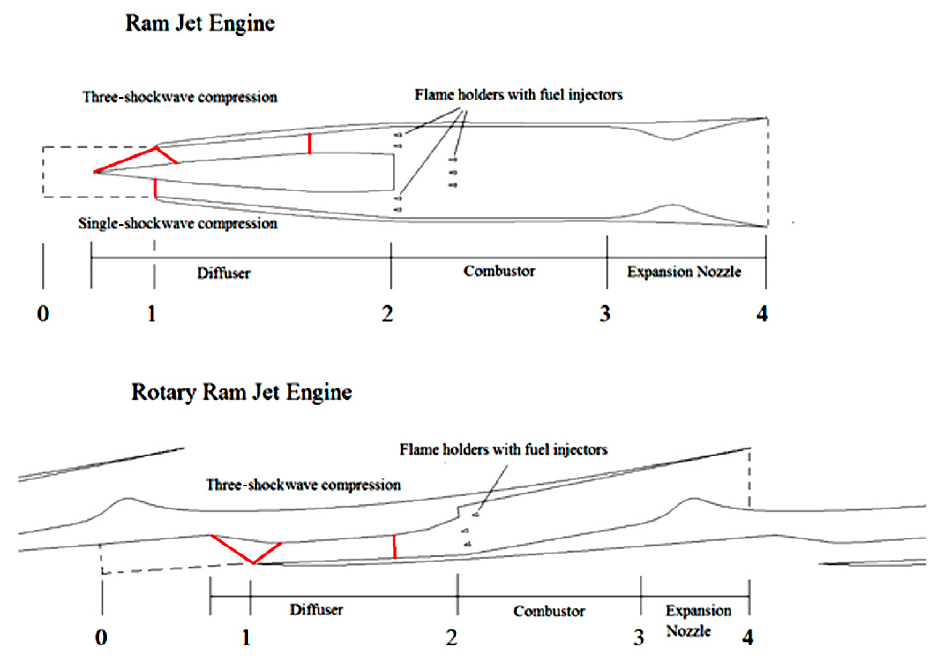
Figure 2. Comparison of axisymmetric geometry of a typical ram jet engine and the planar geometry of the rotary ram jet engine. Markers: 0—define the external conditions, 1—inlet cross-section, 2—combustion chamber inlet, 3—nozzle inlet, 4—nozzle outlet